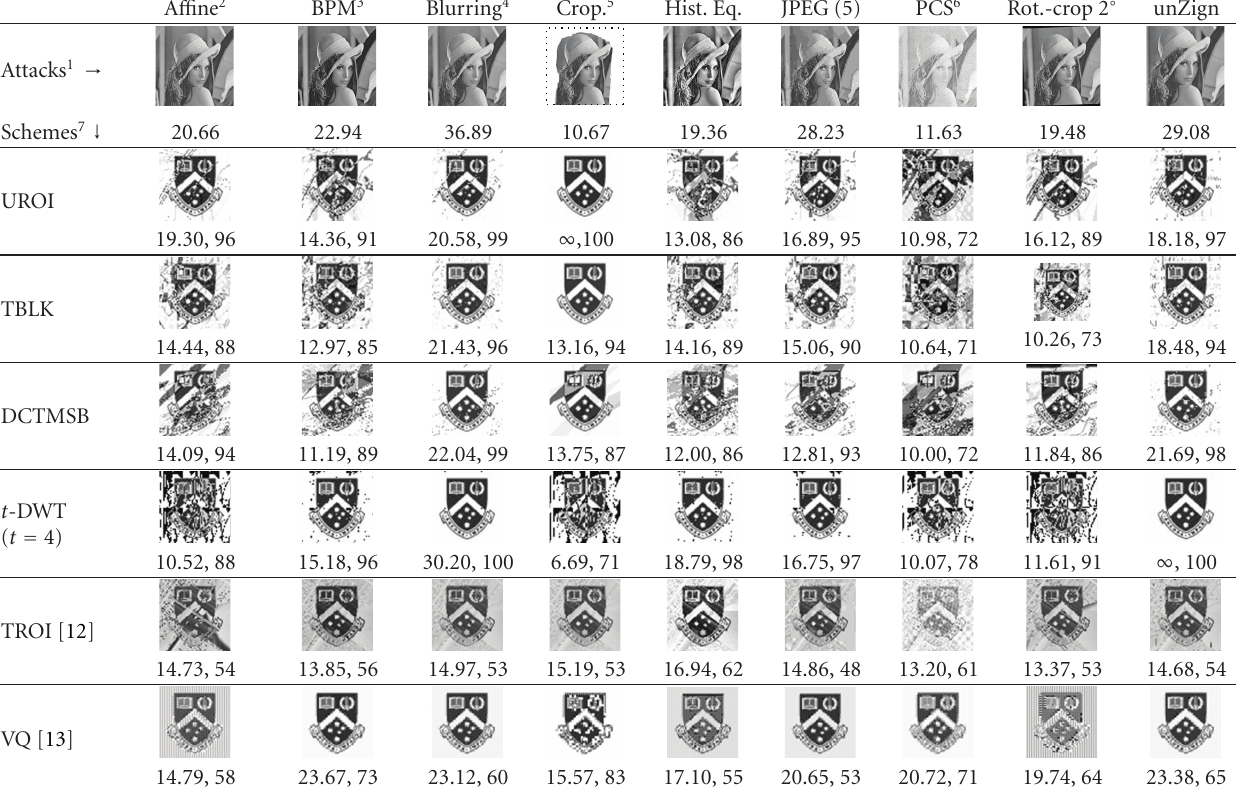
Table 4: Attacked images along with their corresponding retrieved logos using Lena image and Monash logo by di ff erent approaches of the proposed MSB-based scheme and existing TROI-based [12] and VQ-based [13]